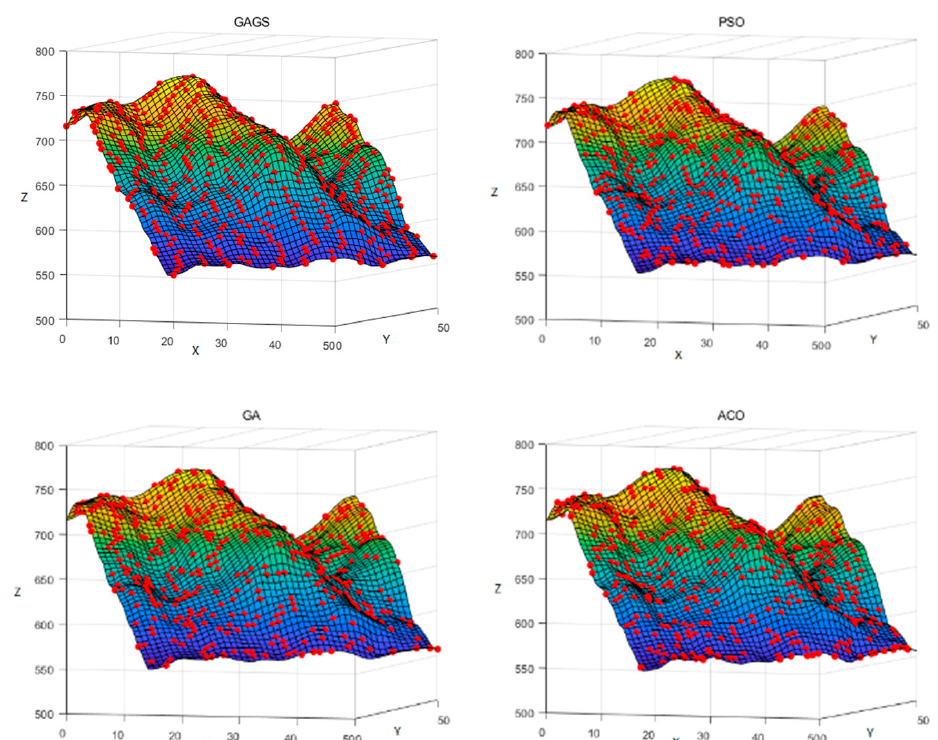
Figure 8. Node deployment under the general terrain model.